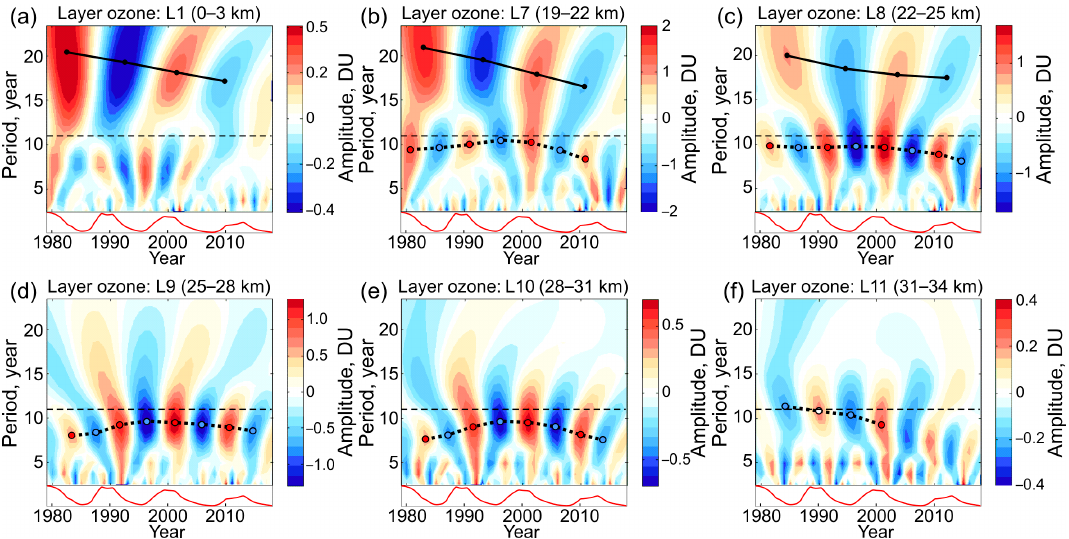
Figure 6. As in Figure 5a,d, but for SBUV layer ozone over Faraday / Vernadsky at ( a ) 0–3 km altitudes (L1) and ( b – f ) 19–34 km (L7–L11; see Figure 2).